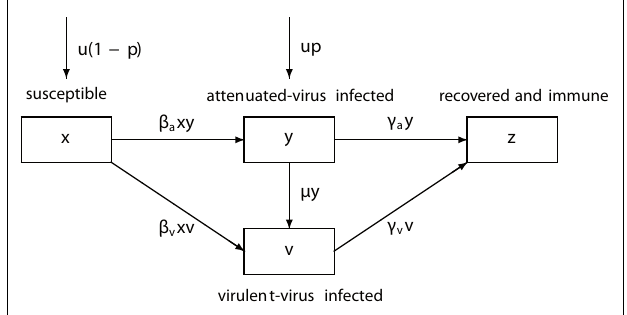
FIGURE 1 |The schematic diagram of the epidemiological dynamics. β a and β v : the transmission rate of attenuated and virulent virus, γ a and γ v : the recovery rate of attenuated and virulent virus, μ : the mutation rate from attenuated to virulent virus, u : the host birth rate ( = death rate), p : the fraction of newborns immunized by OPV.The flows by natural host mortality are